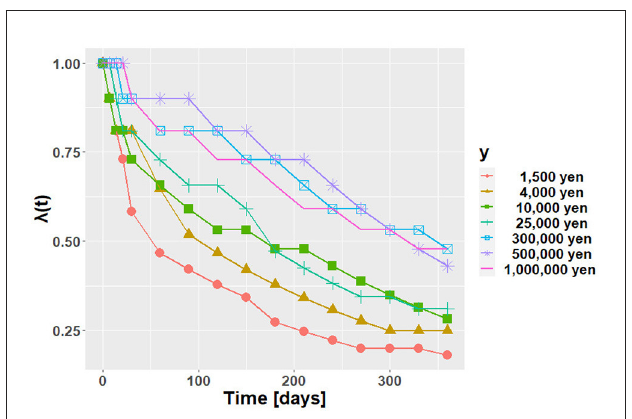
FIGURE6 Comparison of model D, HDM, and